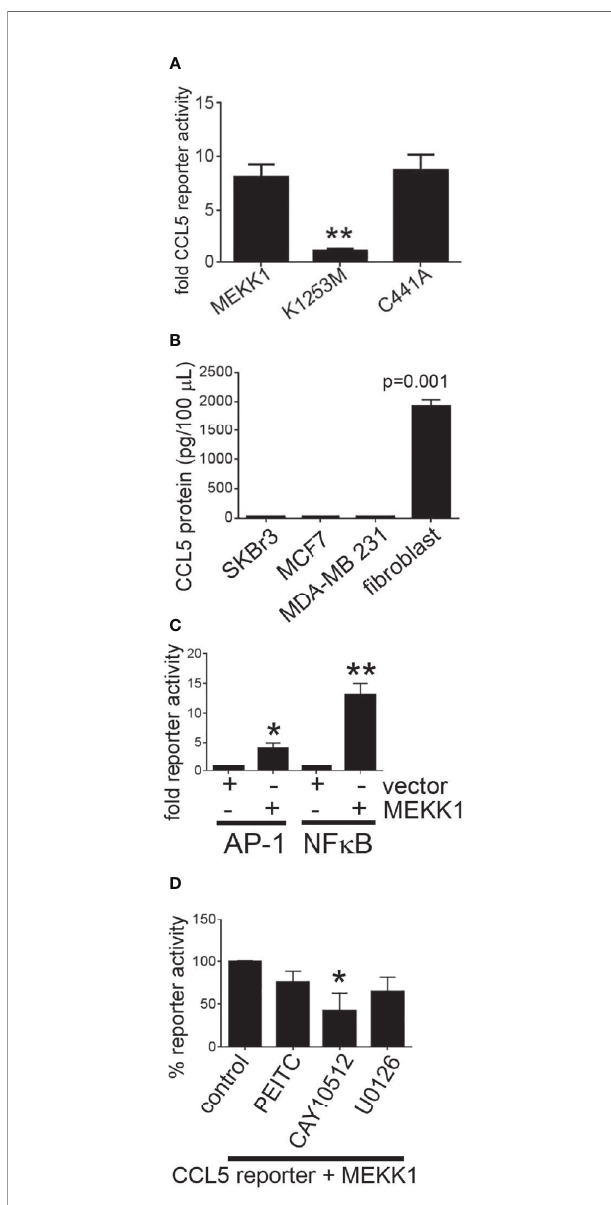
FIGURE 4 | MEKK1 kinase activity, but not ubiquitin ligase activity, is required to induce CCL5 expression. Gene reporter and ELISA analysis are used to determine whether transfection of kinase-inactive mutant MEKK1 (K1253M) or ubiquitin ligase-inactive mutant MEKK1 (C441A) induces CCL5 expression. (A, D) Graphs depict CCL5 reporter analysis of mammary fi broblasts transfected with the pGL2-CCL5-220 luciferase reporter vector and a pCDNA3.1/MEKK1 expression vector. **p < 0.01 by t-test. (B) CCL5 ELISA analysis of cell culture supernatant from both multiple breast tumor cell lines compared to cell culture supernatant of cancer-associated mammary fi broblasts. (C) Graph shows both AP-1 and NF k B reporter analysis of mammary fi broblasts transfected with either the pGL2-AP-1 or pGL2- NF k B luciferase reporter vector and a pCDNA3.1/MEKK1 expression vector or pCDNA3.1 empty vector. (D) CCL5 reporter assay analysis showing effect of chemical inhibitors on CCL5 reporter activity. Cells were treated for six hours prior to lysis with the following drugs concentrations: (MEK inhibitor, 10 ng/ml, n = 3), CAY10512 (NF k B inhibitor, 1.3 m g/ml, n = 3), and PEITC (0.3 m